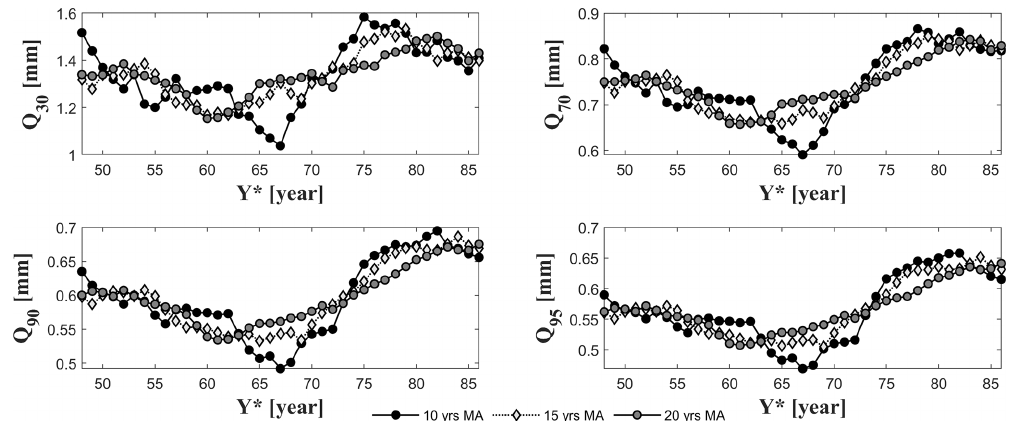
Figure 13. Moving average (MA) of the 30th, 70th, 90th and 95th percentiles of daily streamflow values gauged at Tangipahoa. Three different fixed time windows are used to estimate the MA: 10, 15 and 20 years. On the x axis the first year of each interval is plotted ( Y ∗